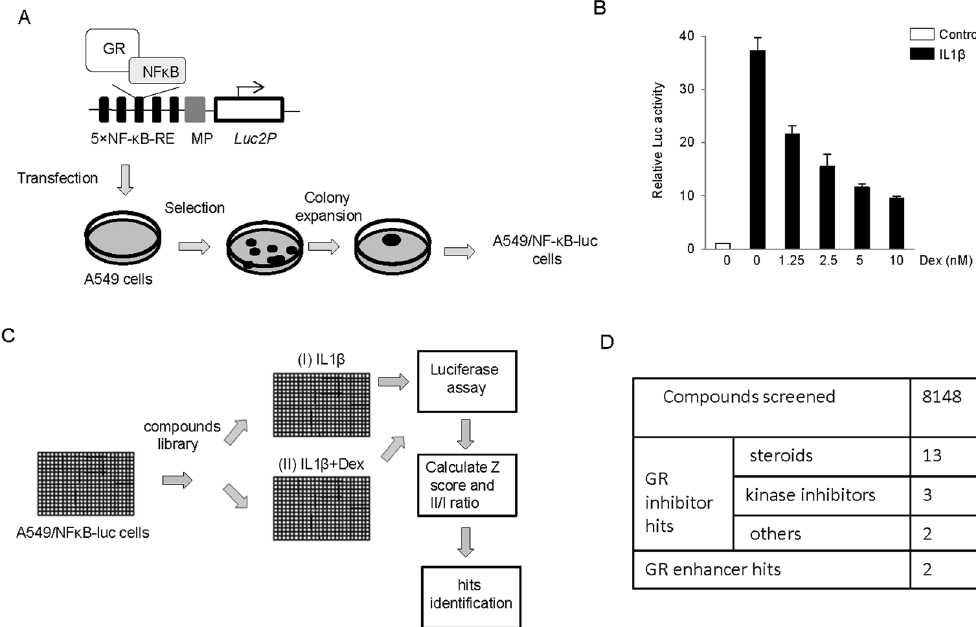
Figure 1. A high-through chemical screen to identify GR modulators. ( A ) Establishment of a stable reporter cell line A549/NF- κ B-luc to assay tethered trans-repression of NF- κ B activation by GR. A plasmid in which five tandem NF- κ B responsive elements (5 × NF- κ B-RE) was put upstream of mini promoter (MP) to control Luc2P expression was stably transfected into A549 cells. The individual colonies were selected, expanded and characterized. ( B ) A549/NF- κ B-luc reporter cells were sensitive to IL-1 β in NF κ B activation and sensitive to Dex in NF- κ B repression by GR. Cells were treated with 5 ng/mL IL-1 β ± Dex as indicated for 18 h and Luciferase assay was performed. ( C ) Schematic representation of the chemical screen design. A549/NF- κ B-luc reporter cells were seeded in 384 well plates, and library compounds were added to the cell plates. One hour later, 5 ng/mL IL-1 β was added to assay I plates and 5 ng/mL IL-1 β + 2.5 nM Dex was added to assay II plates. Luciferase assay was performed after 18 h treatment and MAD based Z scores for each well and ratio II/I of each tested compound were calculated. The inhibitor and enhancer hits were selected based on predefined criteria (see Results ). ( D ) Summary of the GR inhibitors and enhancers identified in the